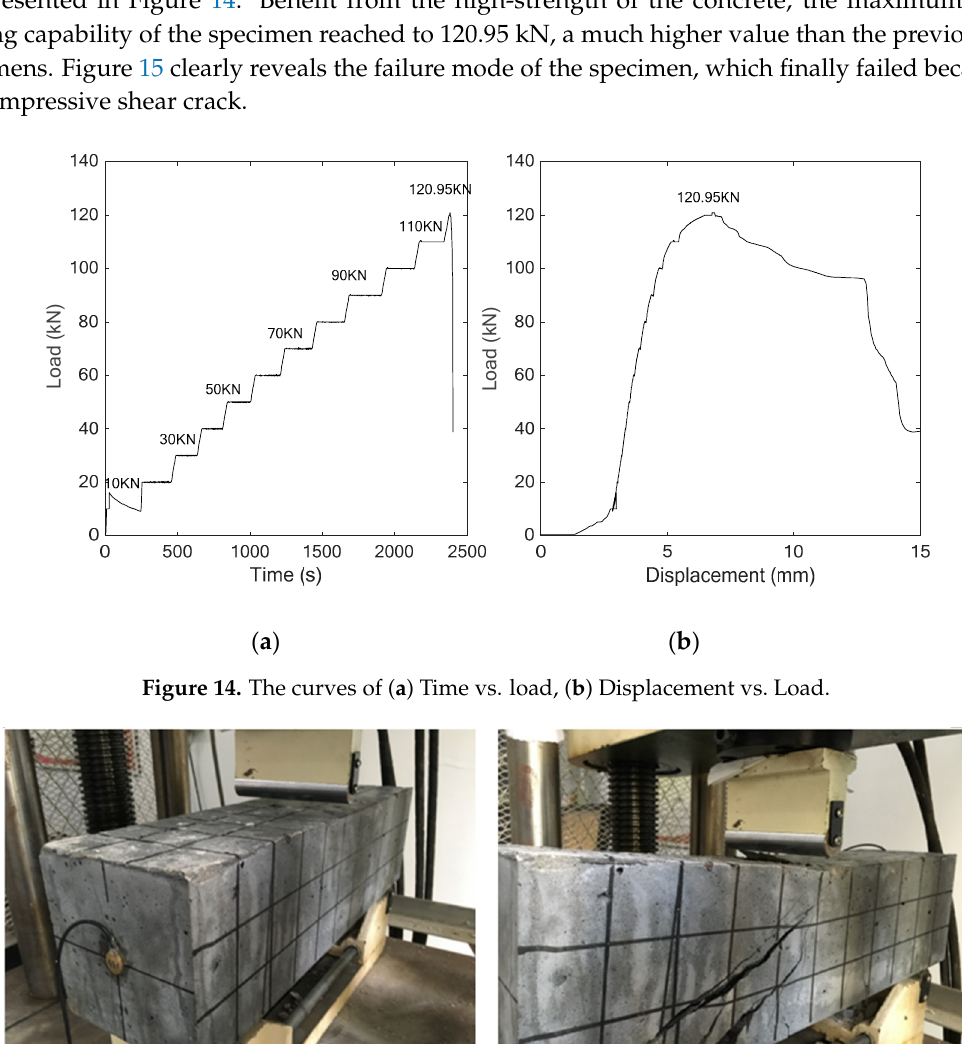
Figure 16. The received signal of the sensor for the specimen with the SCFRP strengthening.